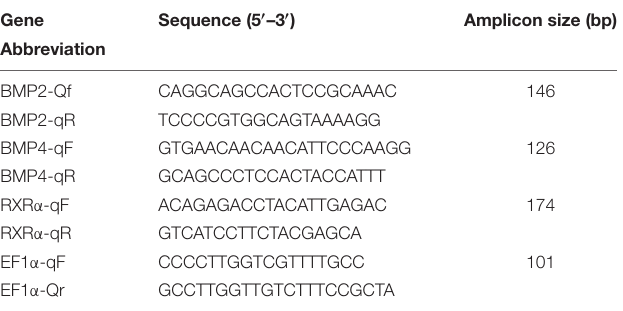
TABLE 1 | Primers of bone morphogenetic protein 2 (BMP2), bone morphogenetic protein 4 (BMP4), retinoid X receptor α (RXR α ), and extension factor 1 α (EF1 α ) genes in golden pompano used in